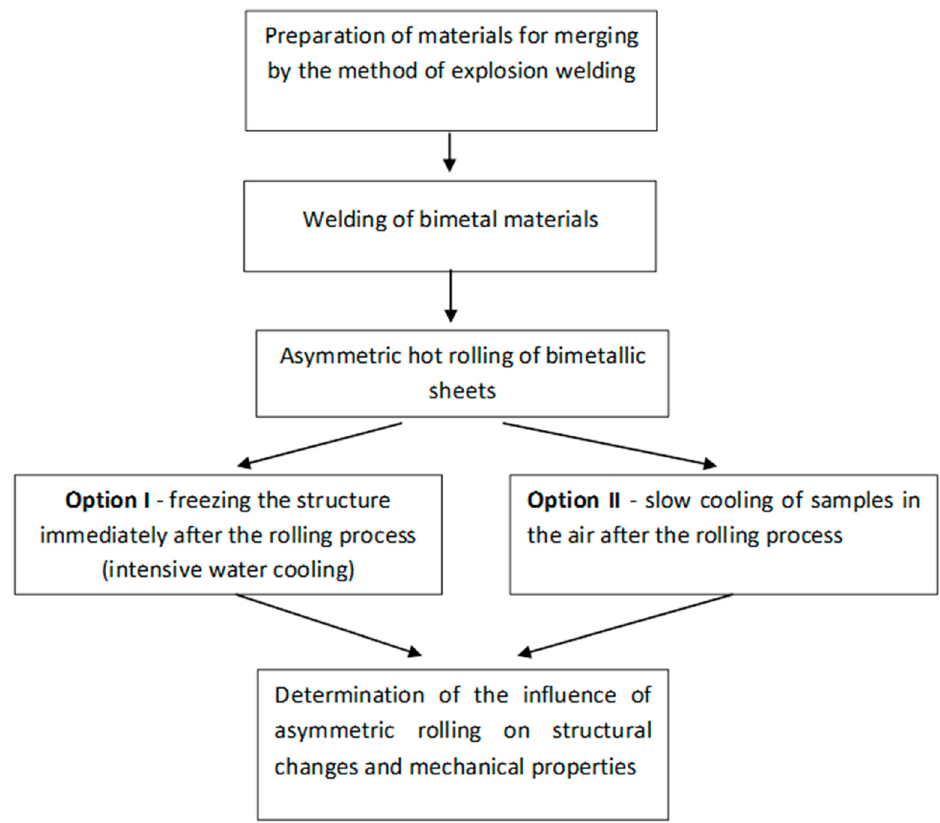
Figure 3. Scheme of research made in the work.